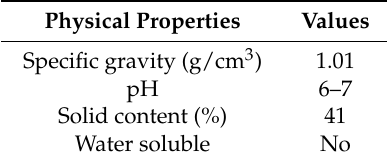
Figure 1. Different states of the aqua-dispersing-nano-binder (ADNB) polymer emulsion: ( a ) initial state (left), dispersed in water (right); ( b ) after water evaporation, an elastic film is generated. Table 2. Characteristics of the organic polymer emulsion.